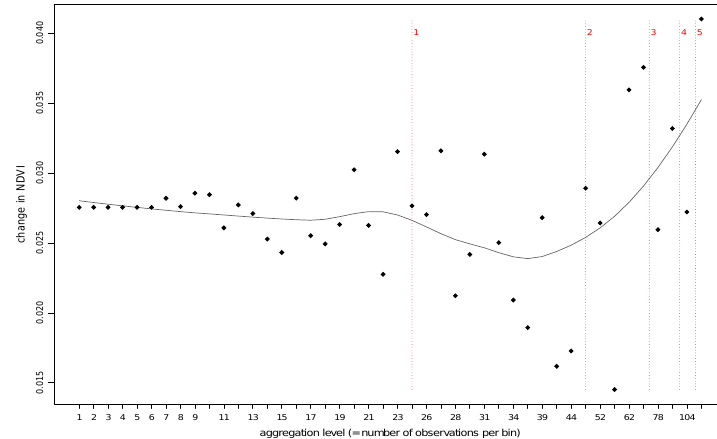
Fig. 3. Change in NDVI detected using linear models depending on the temporal aggregation level. The plot illustrates the MTUP effect for an AVHRR pixel with significant ( p < 0 . 05) trend component (location: 46.21N/110.65E, Montana, USA). See the caption of Fig. 2 for additional information and Table 2 for the NDVI values corresponding to full-year aggregation levels.